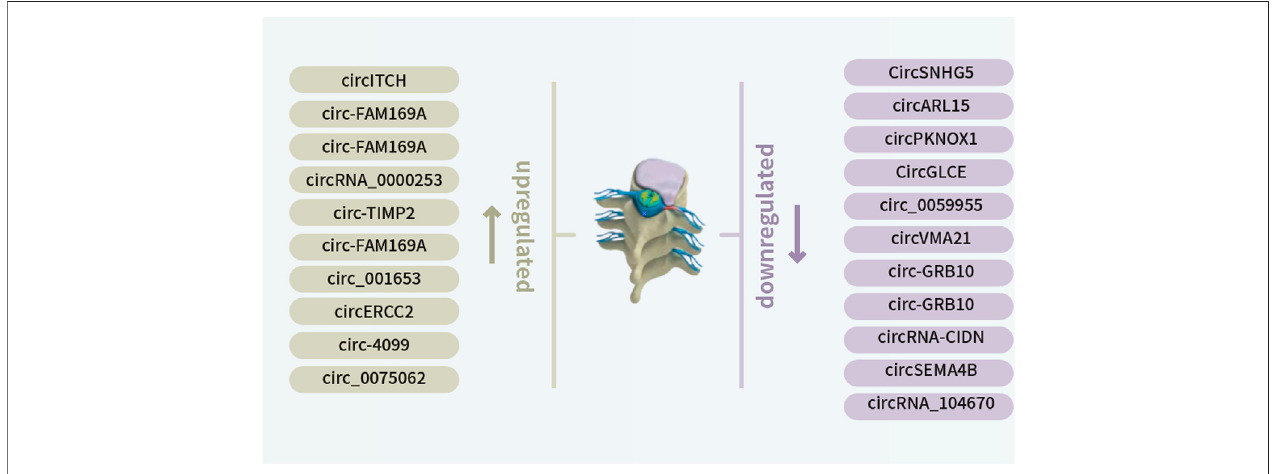
FIGURE 1 | Newly identi fi ed differentially expressed circRNAs in IDD, including 10 downregulated and 11 upregulated